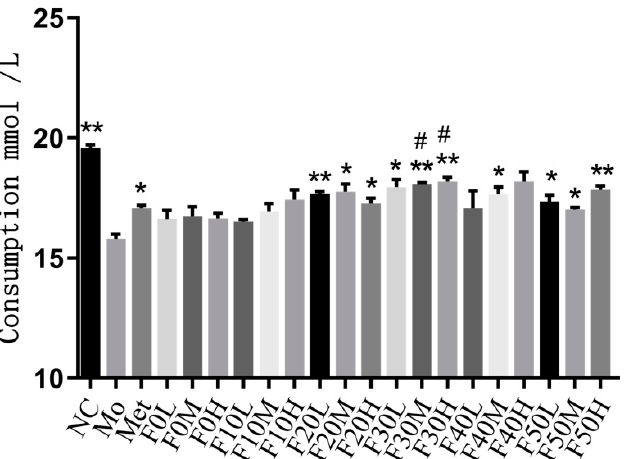
Figure 10. Effects of macroporous resin fractionated eluates on glucose intake in IR-HepG2 cells. NC: control group, Mo: model group, Met: drug group. “*” and “**” represent p < 0.05 and p < 0.01 compared with the Mo group, respectively. “#” indicates p < 0.05 compared with the Met